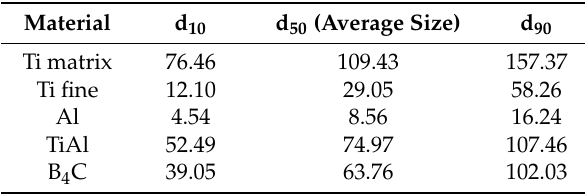
Table 1. Particle-size distribution of the raw